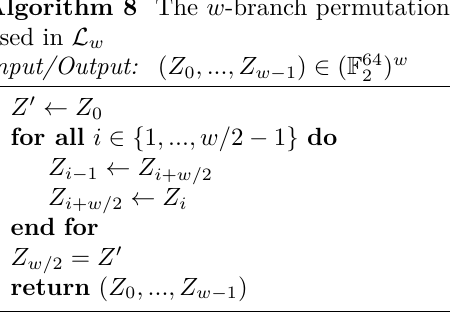
Algorithm 8 The 𝑤 -branch